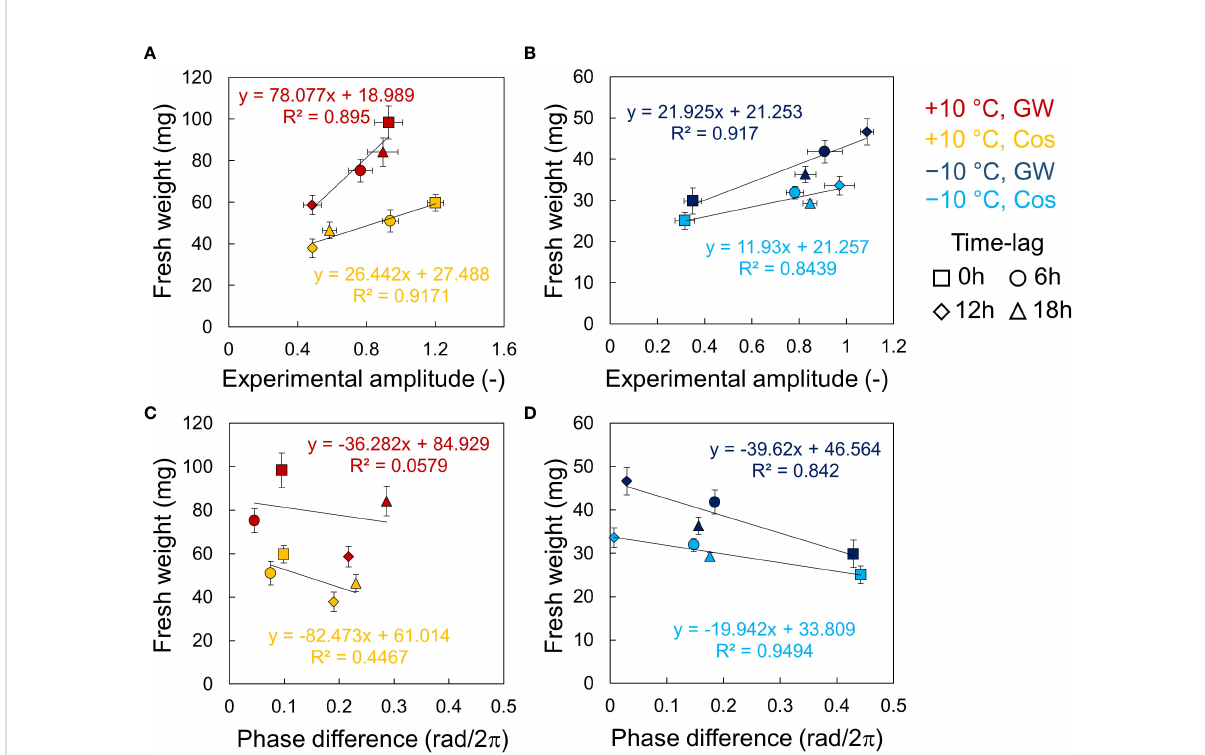
FIGURE 5 Relationship between fresh weights of leaf lettuce ( Lactuca sativa L.) and AtCCA1 rhythms in the conditions of L/D = 12/12 h and 12 h ±10°C cycles. (A, B) Relationship between fresh weight and amplitude at +10°C (A) and − 10°C (B) . (C, D) Relationship between fresh weight and Dq 1 at +10°C (C) and − 10°C (D) . Error bars indicate standard error. The solid lines indicate regression lines. The value of R 2 indicates the correlation coef fi cient of determination.